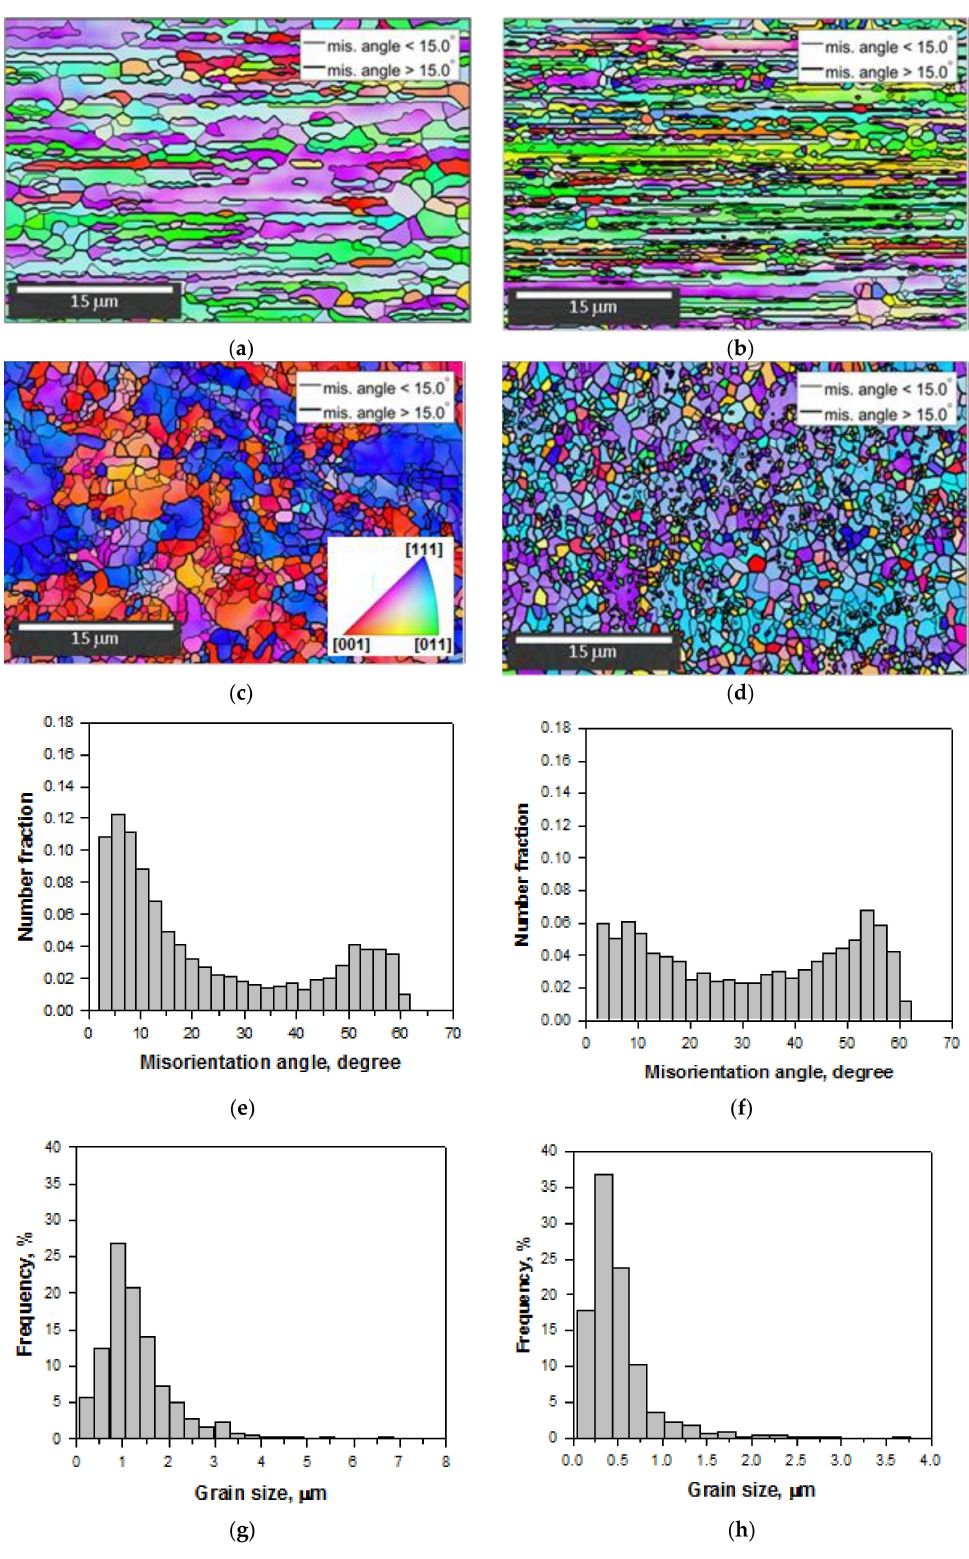
Figure 5. The Al 6101 alloy EBSD maps in longitudinal section: ( a ) T81; ( b ) ECAP-Conform, AA and CD; in cross section: ( c ) T81; ( d ) ECAP-Conform, AA and CD; misorientation angle distribution, cross-section: ( e ) T81; ( f ) ECAP-Conform, AA and CD; grain size distribution, cross-section: ( g ) T81; and ( h ) ECAP-Conform, AA and